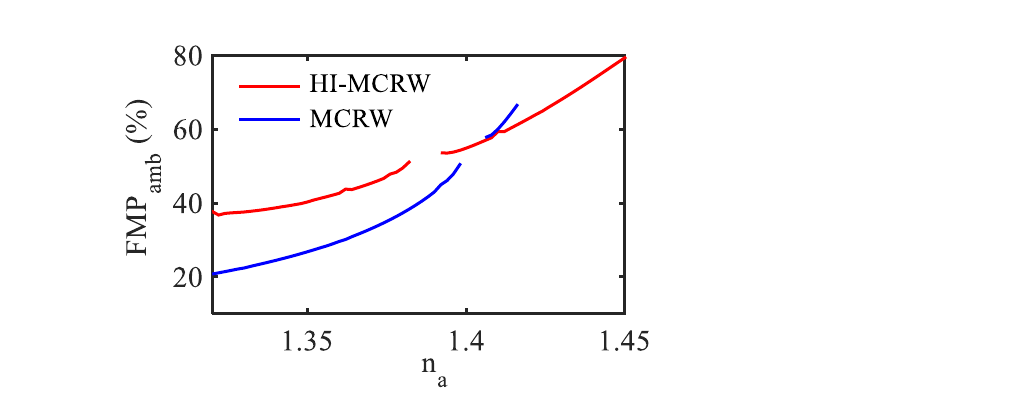
Figure 6. FMP at the ambient medium for the TE 00 mode as a function of its RI for HI-MCRW and MCRW.